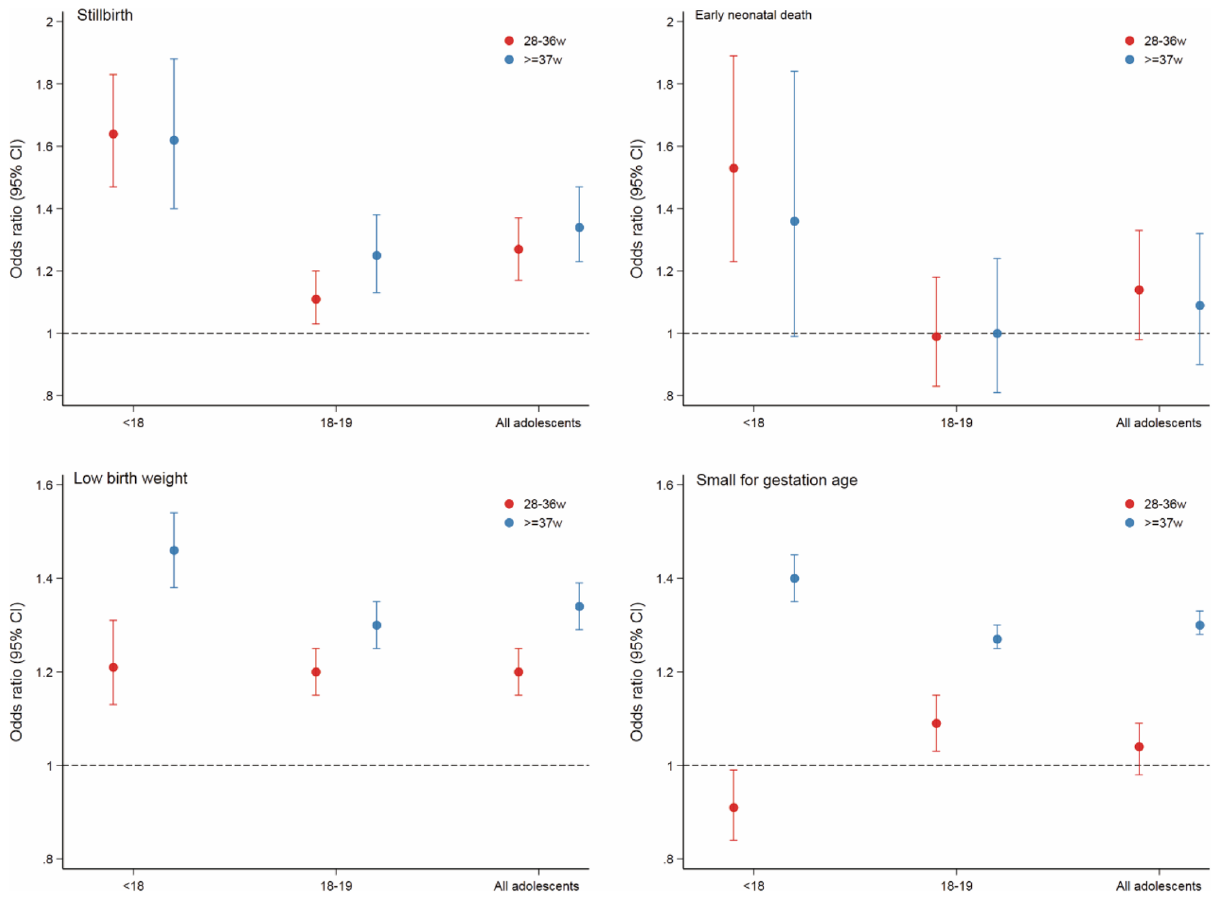
Figure 3. Adjusted odds ratios and 95% confidence intervals of adolescent pregnancies for adverse perinatal outcomes stratified by gestational age, women aged 20–24 years served as the reference